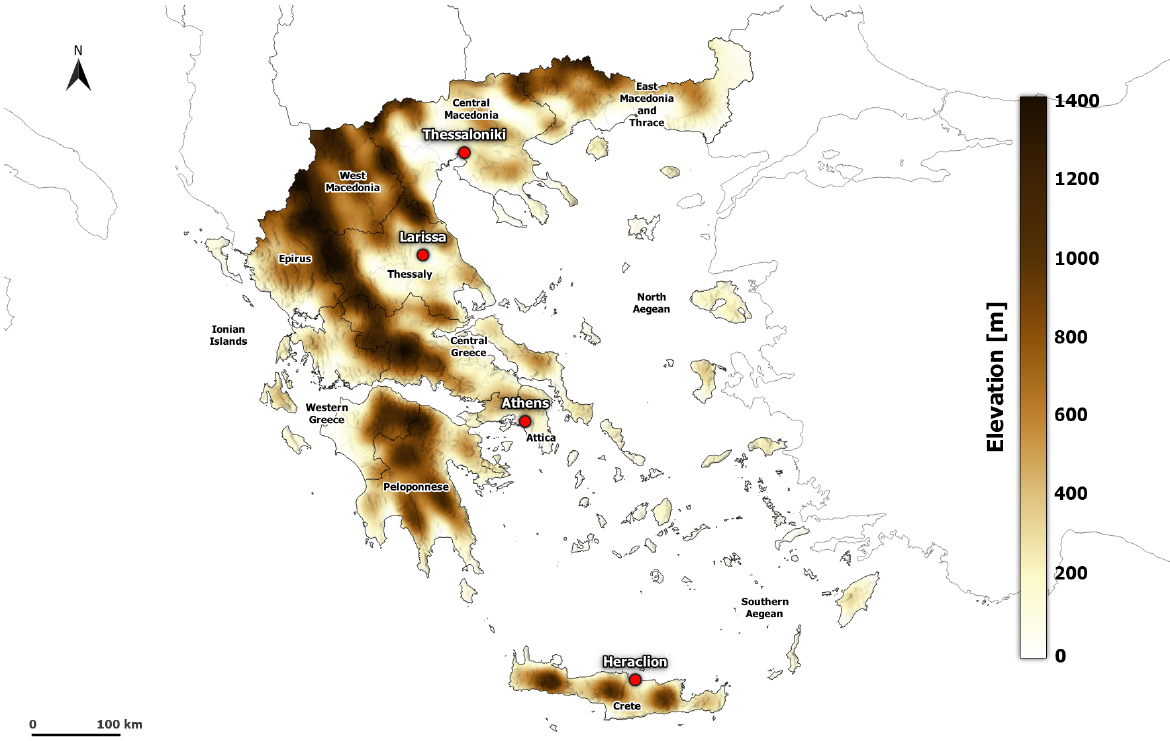
Figure 1. Elevation map of the study area along with the divisions of Greece.